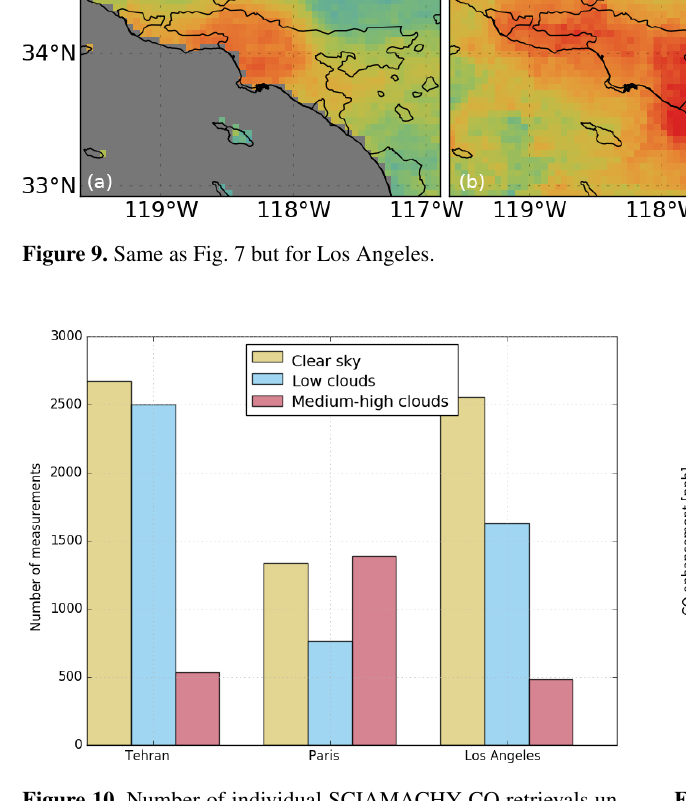
Figure 11. CO enhancement over cities shown in Figs. 7, 8 and 9 relative to the background concentration under clear-sky (yellow), low-cloud (blue) and medium–high-cloud (pink) atmospheric con- ditions. The difference between the median CO concentration inside and outside the urban area contours of each city is